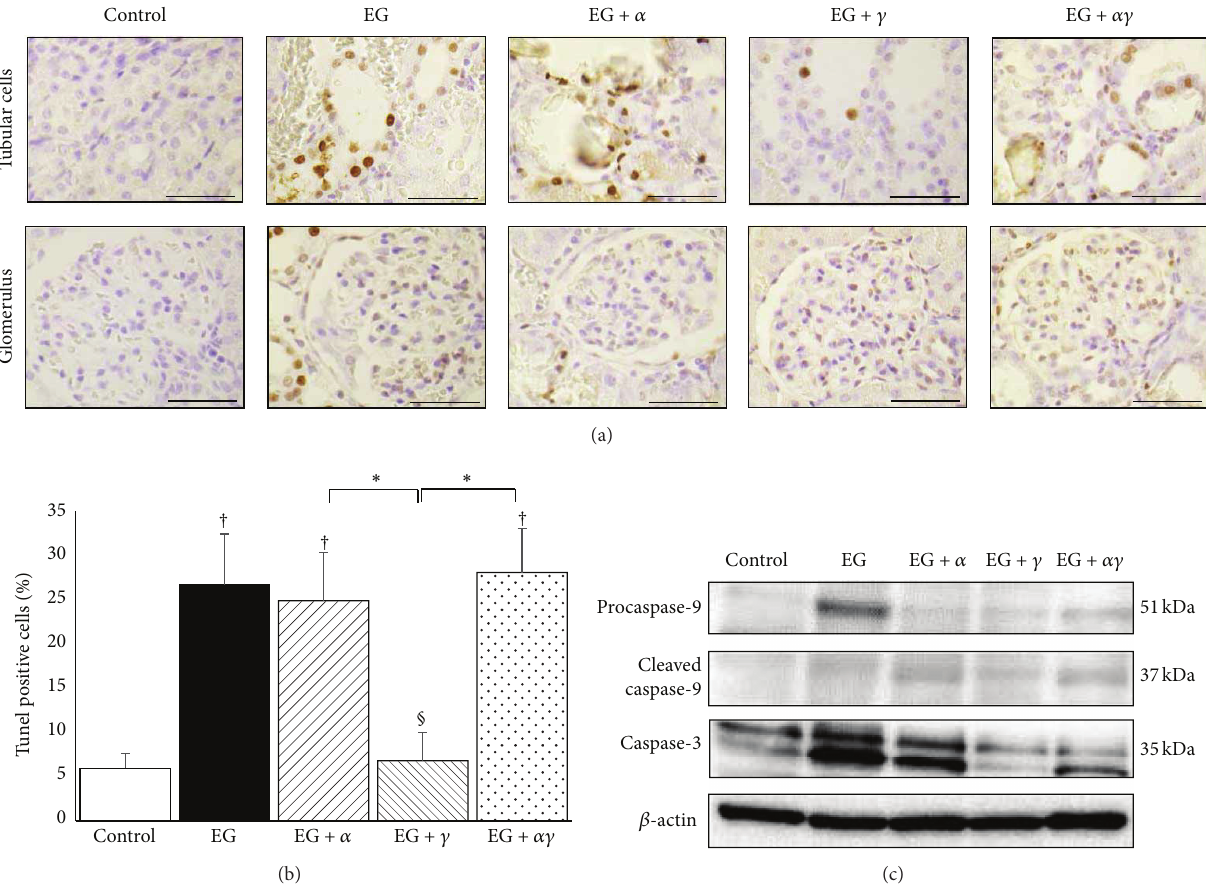
Figure 6: Evaluation for apoptotic cells in model rat kidneys. (a) Representative micrographs of TUNEL-stained renal sections obtained on day 14. Magnification: 400x. Scale bar = 50 𝜇 m. (b) The average number of TUNEL-positive cells per high power field (400x; 𝑛 = 20 fields per group). Data are presented as mean ± SE. ∗ 𝑝 < 0.05 among EG + 𝛼 , EG + 𝛾 , and EG + 𝛼𝛾 groups; † 𝑝 < 0.05 compared to the control group; § 𝑝 <